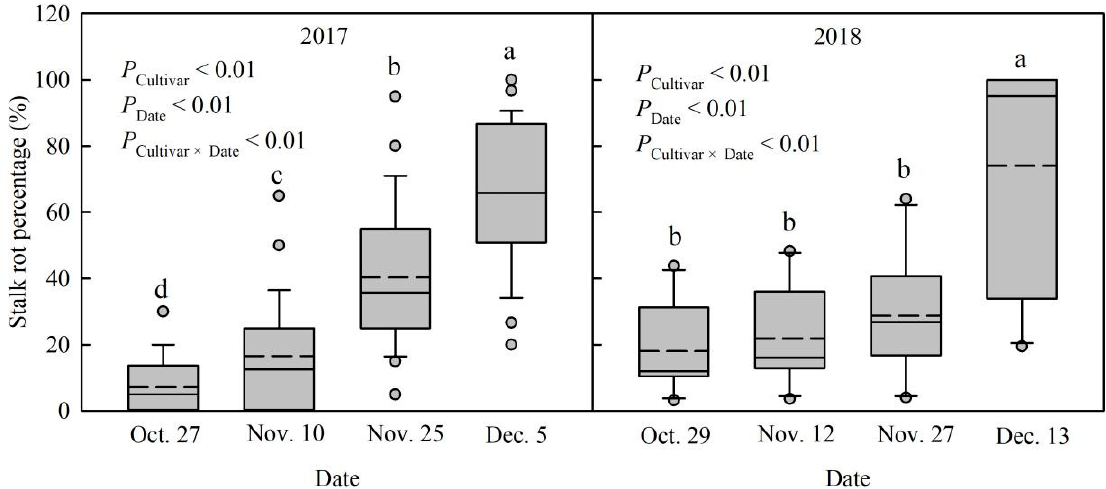
Figure 3. Stalk rot’s natural incidence of different maize cultivars after physiological maturity. The main box designates an IQR containing 50% samples in a Box-whisker Plot. The two sidelines indicate the reasonable sample border in Tukey method. The solid line in box locates the median sample. The hidden line indicates the average value. The circle indicates the outlier. Different lowercase letters indicate significant differences ( p < 0.05) among the harvest dates.